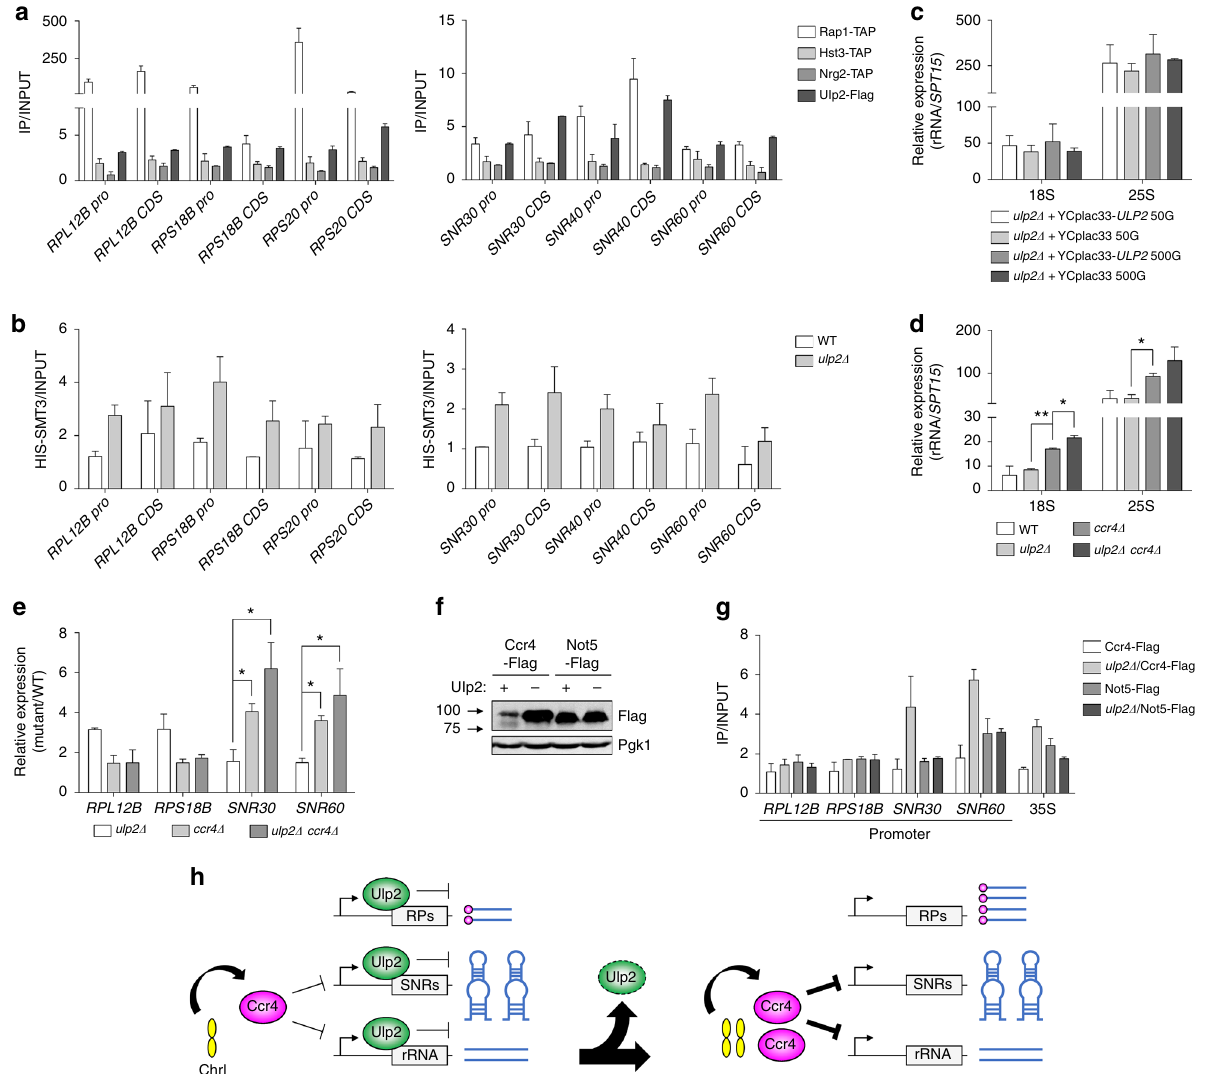
Fig. 3 Ulp2 localizes to ribosomal protein and snoRNA genes and affects local sumoylation. a Chromatin immunoprecipitation (ChIP) analysis using IgG- Sepharose or anti-Flag agarose beads and strains expressing TAP-tagged Rap1, Hst3, or Nrg2 or Flag-tagged Ulp2. Real-time PCR signals at promoter (Pro) and coding sequence (CDS) regions of indicated genes were quantitated and normalized to an internal background control and the input DNA. The error bars indicate the SD calculated from two independent chromatin preparations. b Occupancy of Smt3 at the indicated genes was determined in the WT and ulp2 Δ strains expressing His-tagged Smt3 by ChIP using Ni + 2 -NTA resin and analyzed as shown in a . The error bars indicate the SD from two independent preparations. c , d qRT-PCR analysis of 18s and 25s rRNA in the indicated strains done as in Fig. 2g. Data were normalized to SPT15 expression. The error bars indicate the SD from two independent RNA samples, and asterisks indicate statistically signi fi cant differences (* P < 0.05; ** P < 0.01, two-tailed Student ’ s t -test). e Gene expression analysis of ribosomal protein genes RPL12B and RPS18B and snoRNA genes SNR30 or SNR60 by qRT-PCR assay, performed as in Fig. 2g. Expression was measured relative to WT cells (MHY500). Data were normalized to SPT15 expression. The error bars represent the SD from two independent RNAs, and asterisks indicate statistically signi fi cant differences (* P < 0.05, two-tailed Student ’ s t -test). f Immunoblot analysis of Ccr4-Flag or Not5-Flag in the indicated ulp2 Δ strains. Anti-Pgk1 blotting was used to verify equal loading. g ChIP assay using anti-Flag agarose beads in the indicated strains as shown in a . The error bars indicate the SD from two independent experiments. h Proposed model of transcription of genes required for ribosome biogenesis in ulp2 Δ cells. RPs, SNRs, and rRNA indicate genes of ribosomal proteins, snoRNAs and ribosomal RNA, respectively. Normally, Ulp2 represses transcription of RP, snoRNA, and rRNA genes, and Ccr4 protein, encoded on ChrI, represses expression of snoRNAs and rRNA but not RPs. Loss of Ulp2 leads to ChrI disomy, and the increased level of ChrI-encoded Ccr4 counters the loss of Ulp2-dependent repression of transcription of snoRNA and rRNA, but not RP,